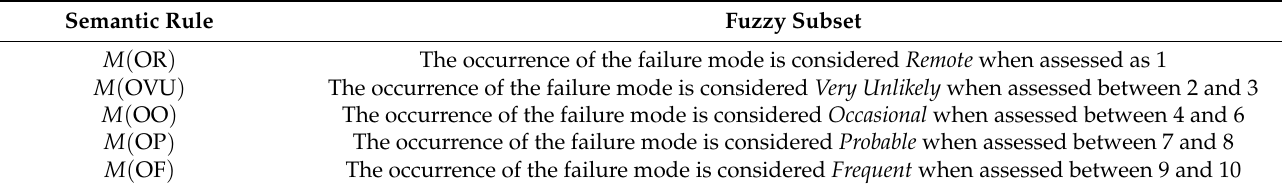
Table 2. Semantic rules for term-set Occurrence .